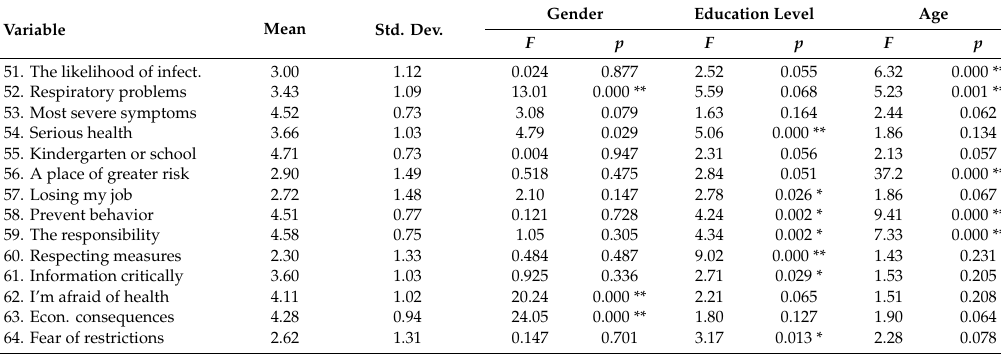
Table 6. One-way ANOVA results of psychological behaviours of citizens and the variables of gender, education level, and age on the risk perception of coronavirus disease. Variable Mean Std. Dev.